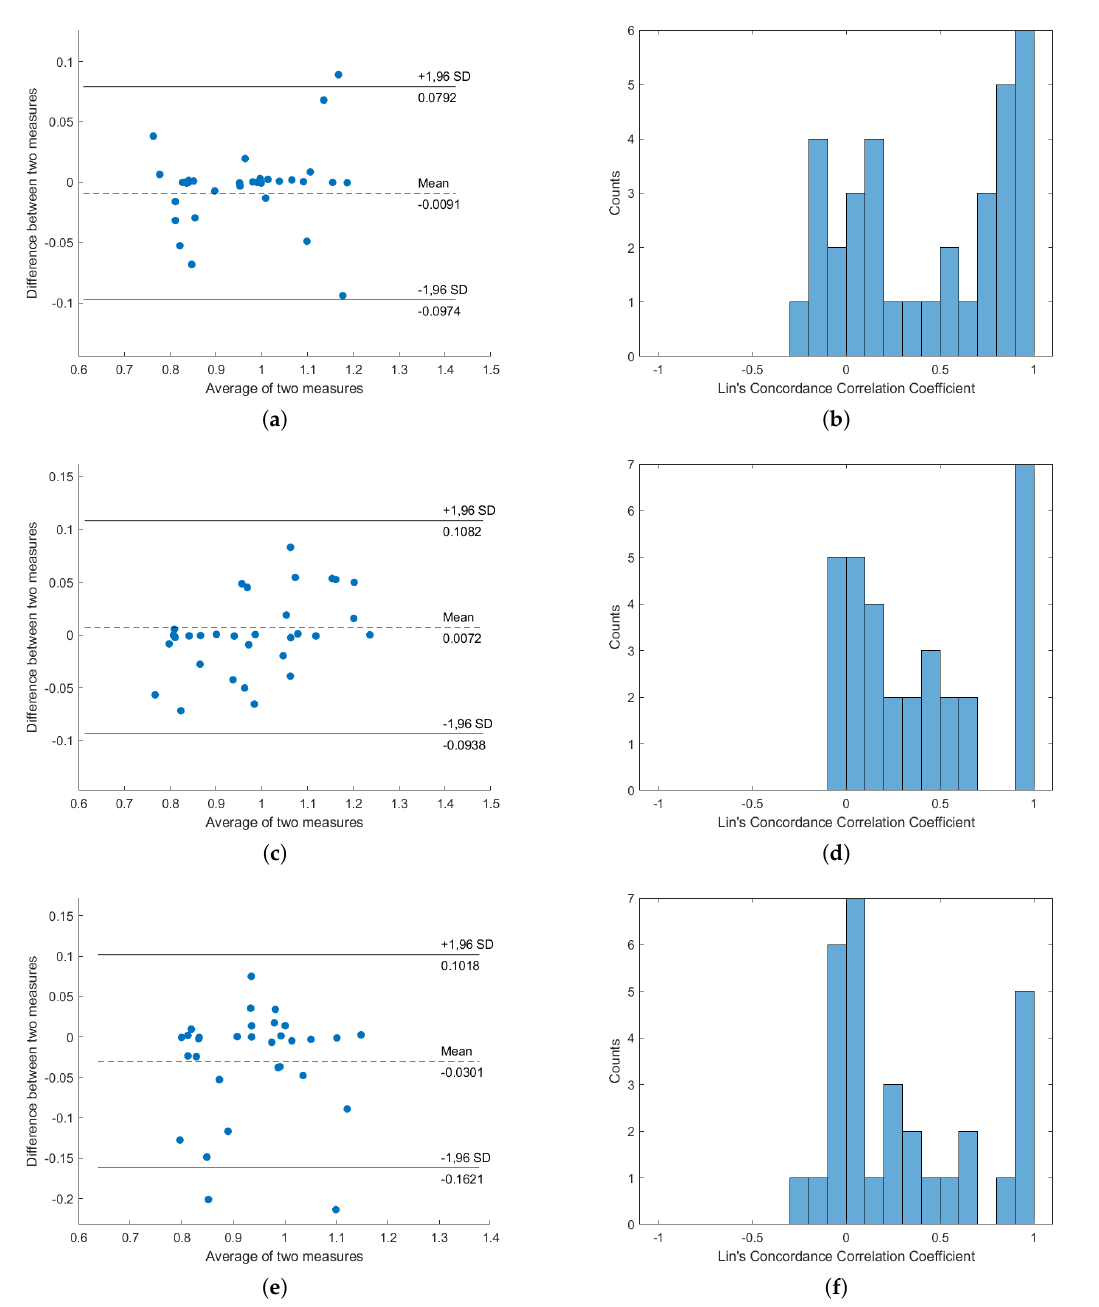
Figure 7. Concordance analysis result, from “Average signal of S1 and S2”. ( a , c , e ) are the Bland–Altman plots for subjects lying on their back, subjects lying on their left, and subjects lying on their right, respectively; ( b , d , f ) are the histograms of Lin’s Concordance Correlation Coefficients for subjects lying on their back, subjects lying on their left, and subjects lying on their right,